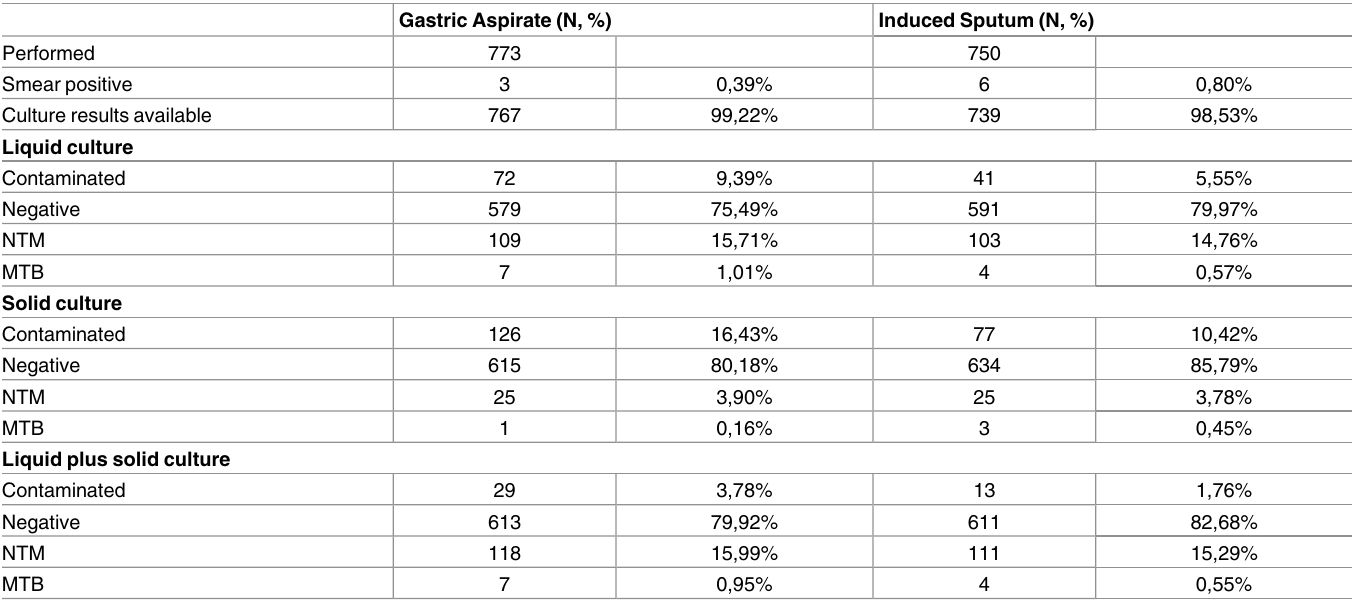
Table 1. Mycobacterial culture results per sample available at admission. Gastric Aspirate (N, %) Induced Sputum (N,